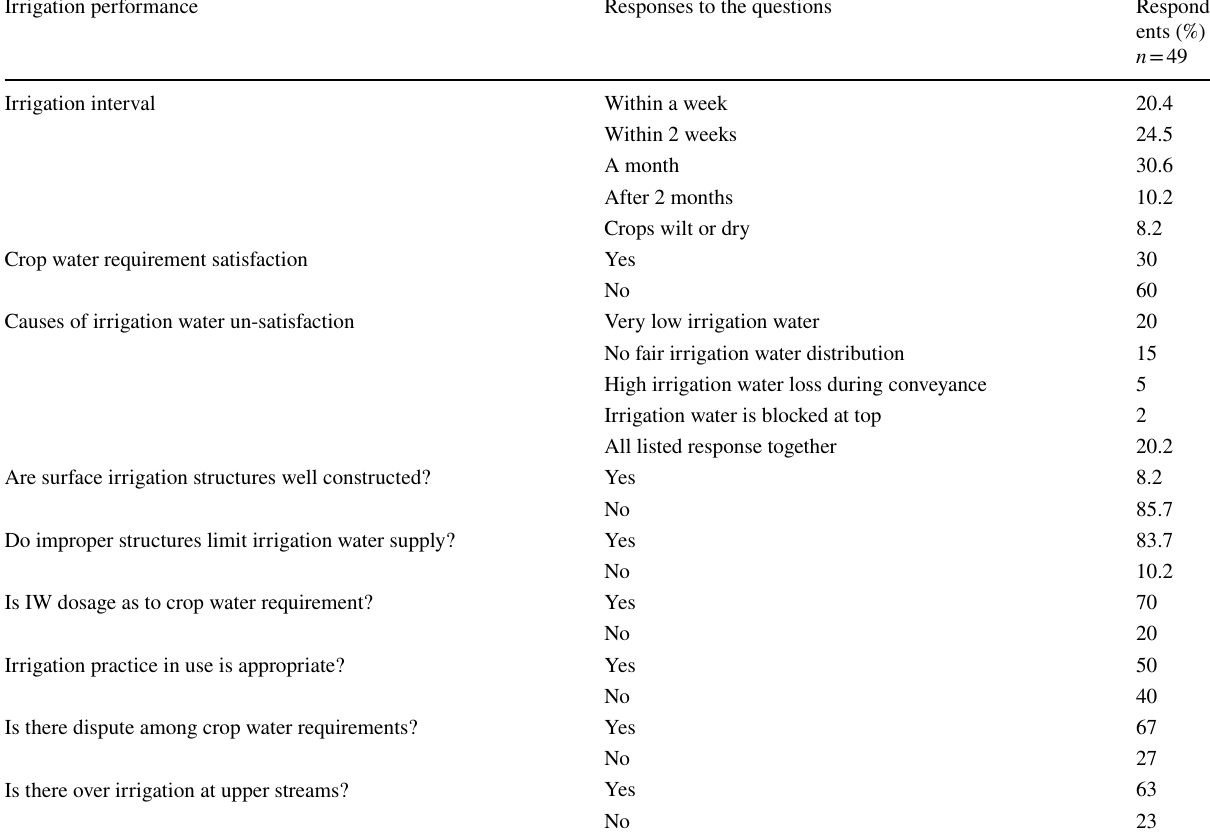
Table 10 Framers perception on performance of irrigation schemes in Cheleleka watershed, central Rift Valley, Ethiopia Irrigation